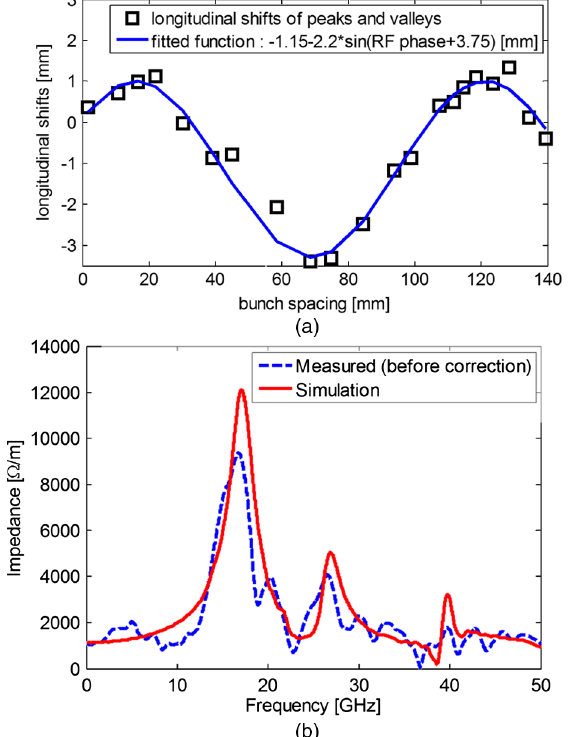
(b) Spectrum of original measured data.